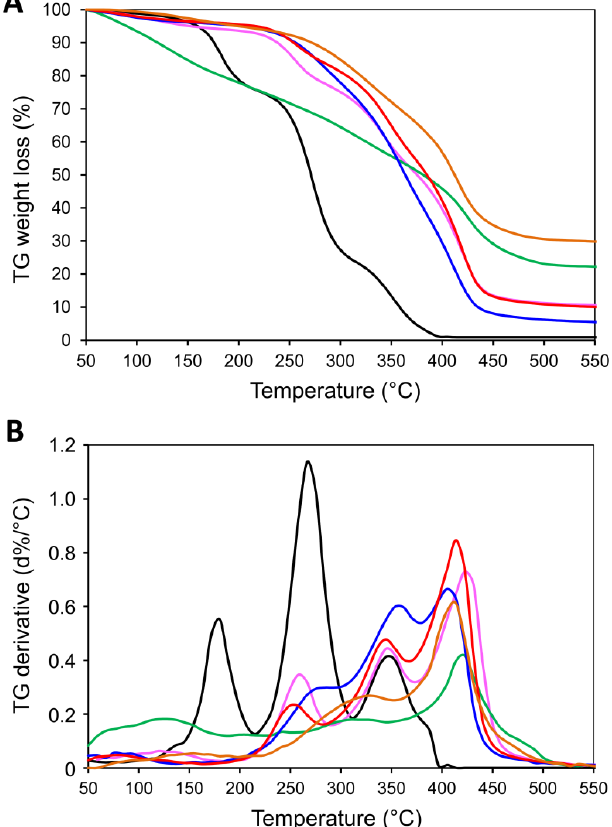
Figure 2. TGA ( A ) and DTG ( B ) of [P(EMA)- co -(GMA)] (black) [P(EMA)- co -(GMA)]-ETA( 1 ) (purple), [P(EMA)- co -(GMA)]-Orn( 1 ) (green), [P(EMA)- co -(GMA)]-Xyl (blue), [P(EMA)- co -(GMA)]-ETA( 2 ) (red), and [P(EMA)- co -(GMA)]-Orn( 2 ) (orange). Measurements were performed in an Ar atmosphere at a rate of 10 °C min − 1 .